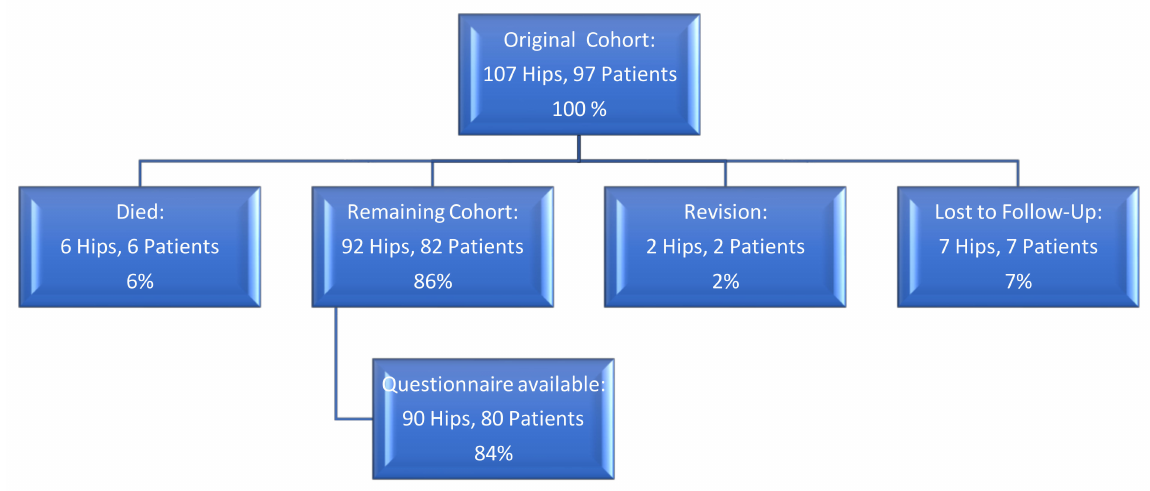
Figure 1. Flowchart illustrating Patient status at most recent follow-up.